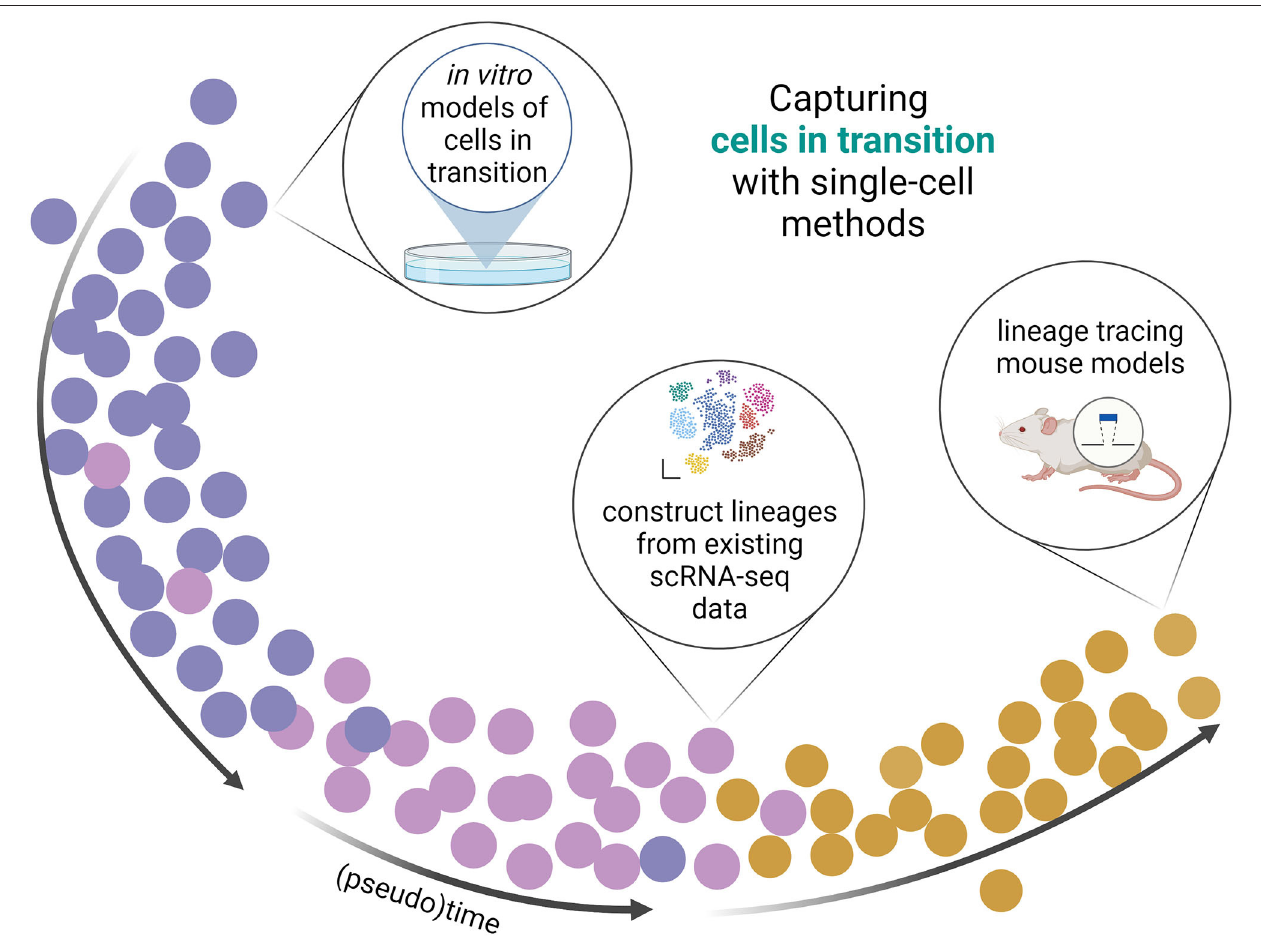
FIGURE 2 | Capturing cells in transition with single-cell methods. Single-cell methods fascilitate the detection of cells in transition. scRNA and/or scATAC facilitate (re)constructing or confirmation of lineages of cells transitioning between phenotypes or cell states. With bioinformatical tools, data from in vitro, in silico , and in vivo experiments can be used to place cells on an artificial timeline (pseudotime) from which the cell transitions can be